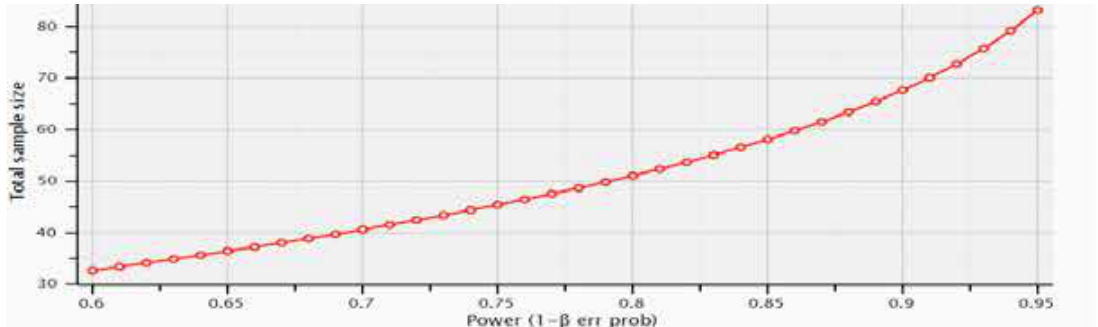
Figure 3. Protocol of power analysis Table 1. Normal distribution of data by utilizing Shapiro-Wilk Test of Normality of bhastrika pranayama intervention (BPI) group and control group of health-related components of physical fitness. Shapiro-Wilk Test of Normality max) (ml/kg/min) Maximal Oxygen Consumption (VO 2